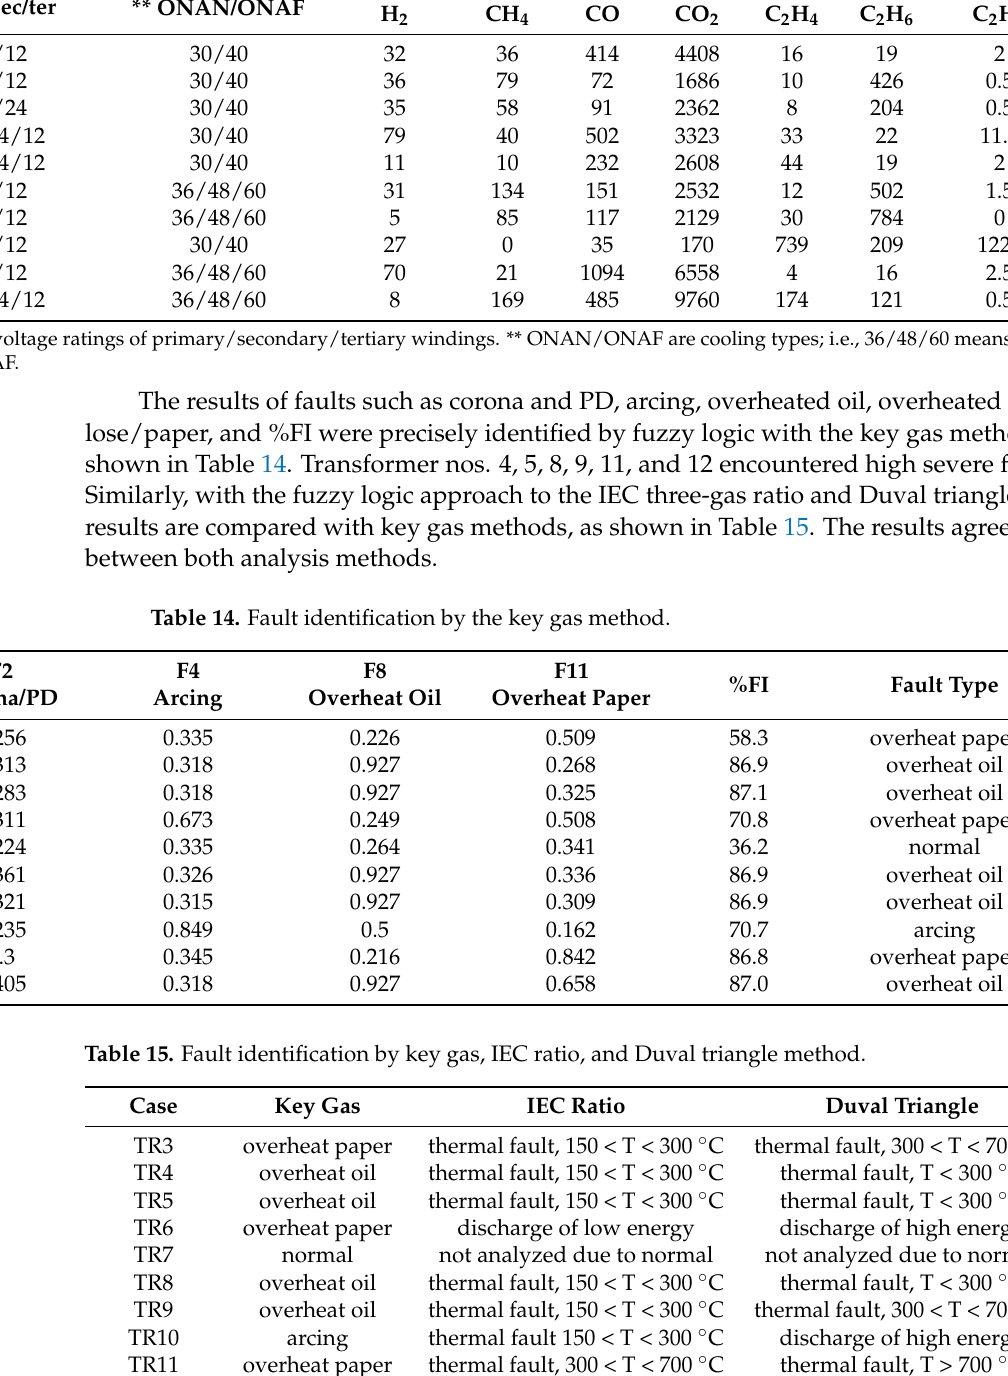
Table 13. Input gases (ppm) from an on-site test with an additional ten power transformers. Case